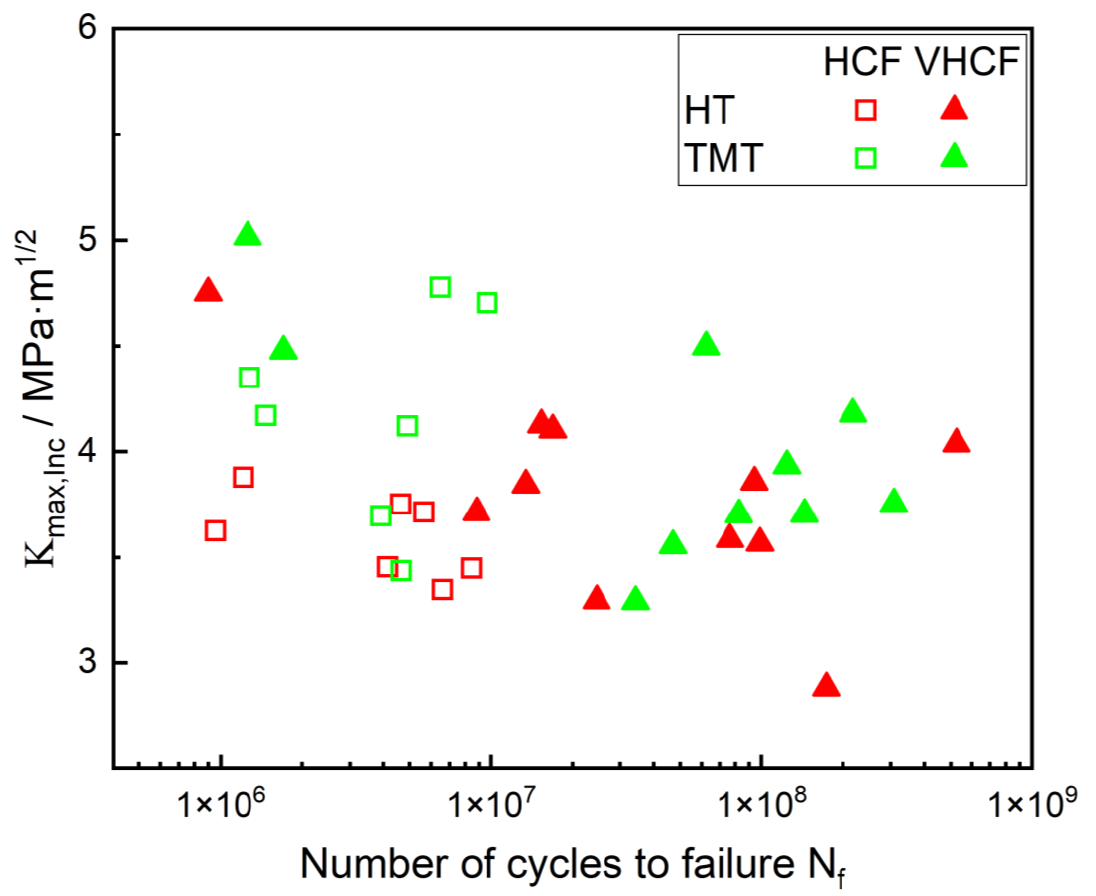
Figure 7. Maximum stress intensity factors K max,Inc at internal critical non-metallic inclusions over lifetime. a